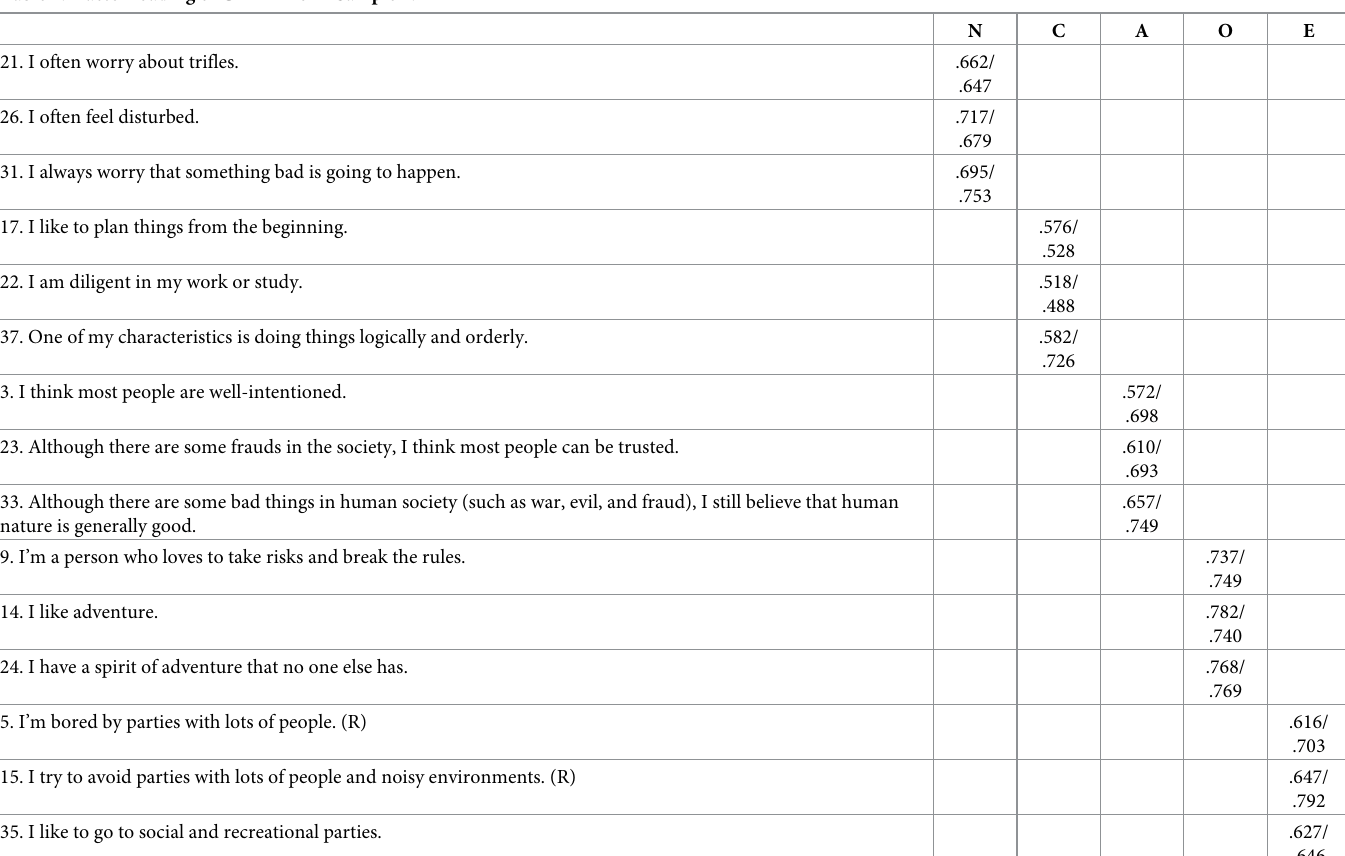
Table 2. Factor loading of CBF-PI-15 in Sample